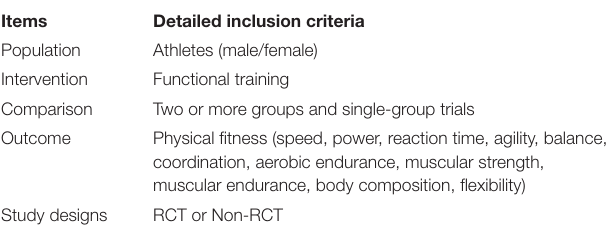
TABLE 1 | Inclusion criteria according to the PICOS conditions. Items Detailed inclusion